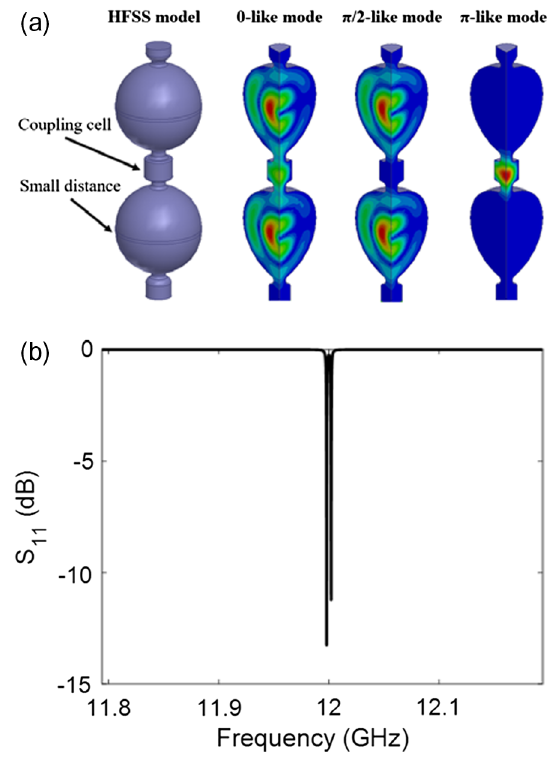
FIG. 10. (a) Field patterns and (b) reflection coefficient of a correction cavity unit.